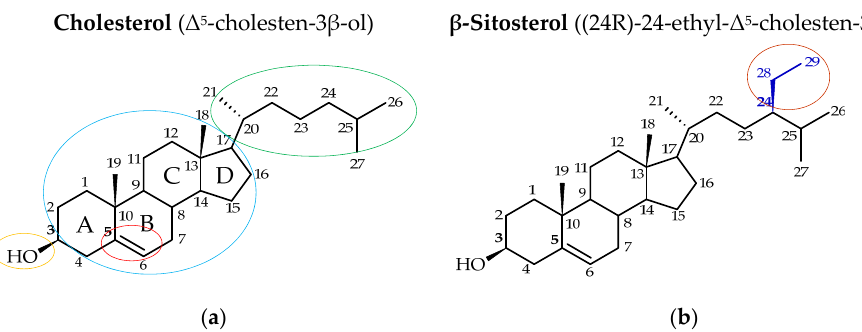
Figure 1. Chemical structures of ( a ) cholesterol and ( b ) β -sitosterol. Blue ellipse: basic skeleton; orange ellipse: hydroxyl group at C3 carbon atom; red ellipse: double bond at C5 and/or C7 carbon atom; green ellipse: side alkyl chain at C17 carbon atom; brown ellipse: ethyl group at C24 carbon atom.